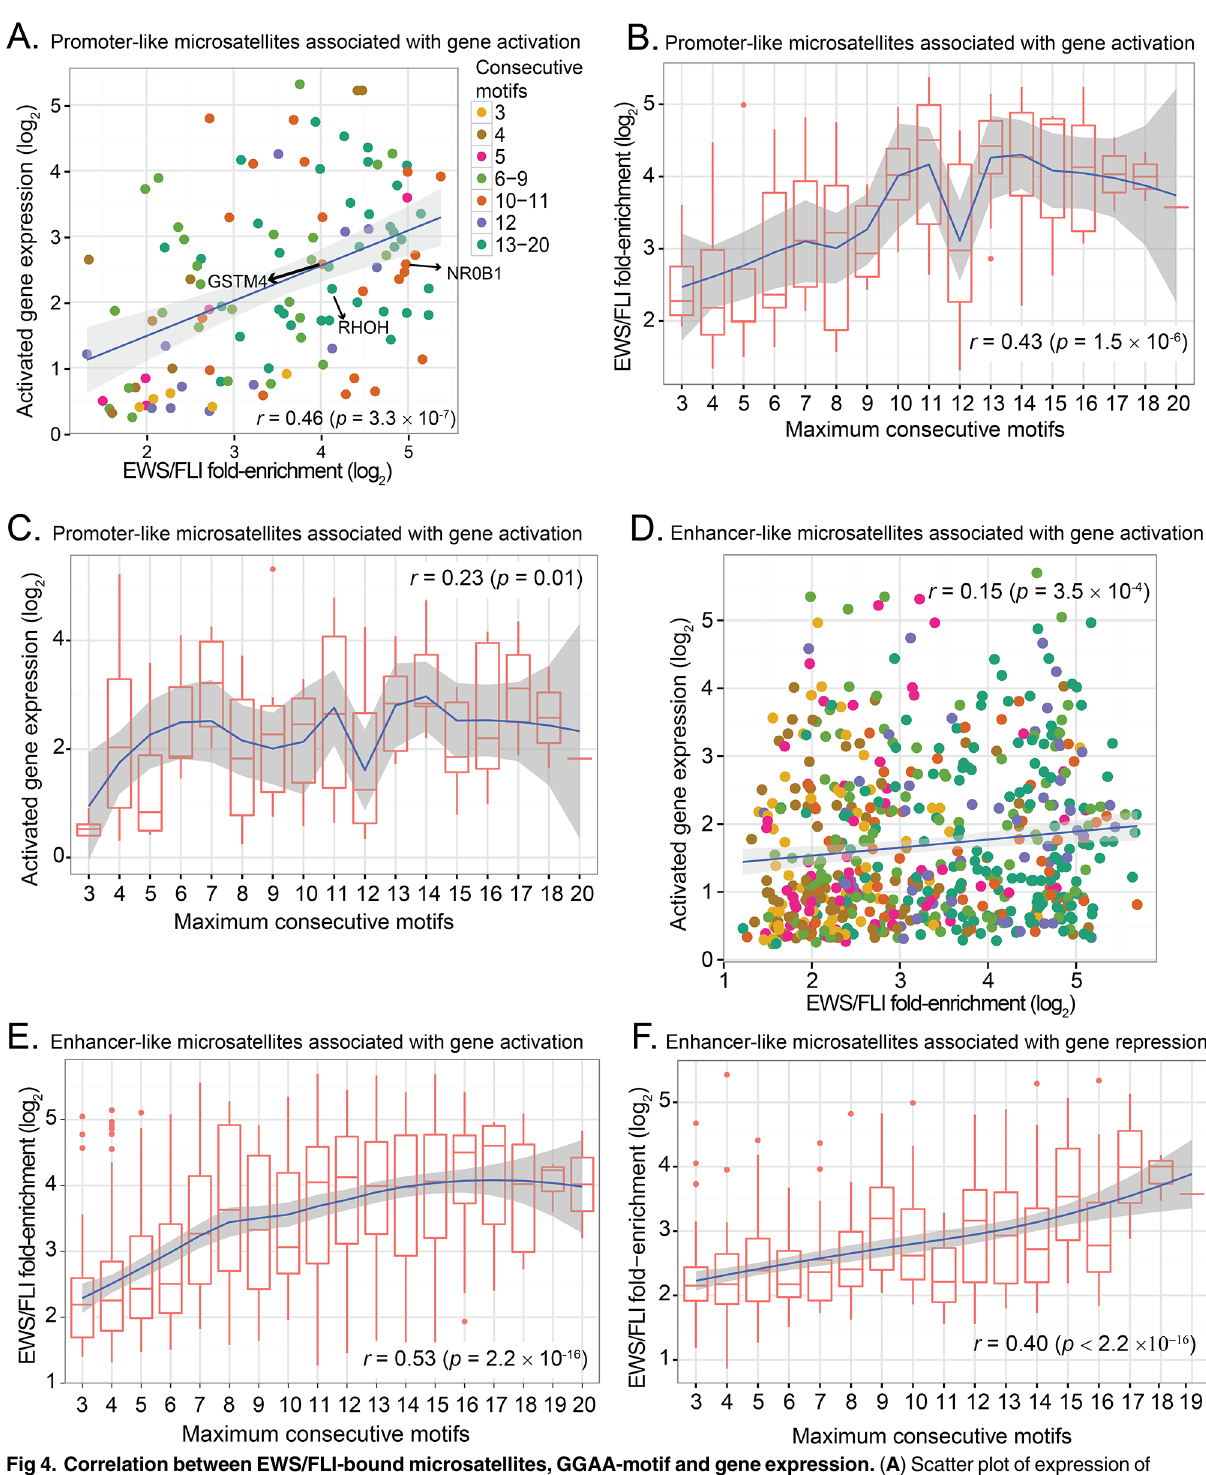
PLOS ONE | https://doi.org/10.1371/journal.pone.0186275 November1,